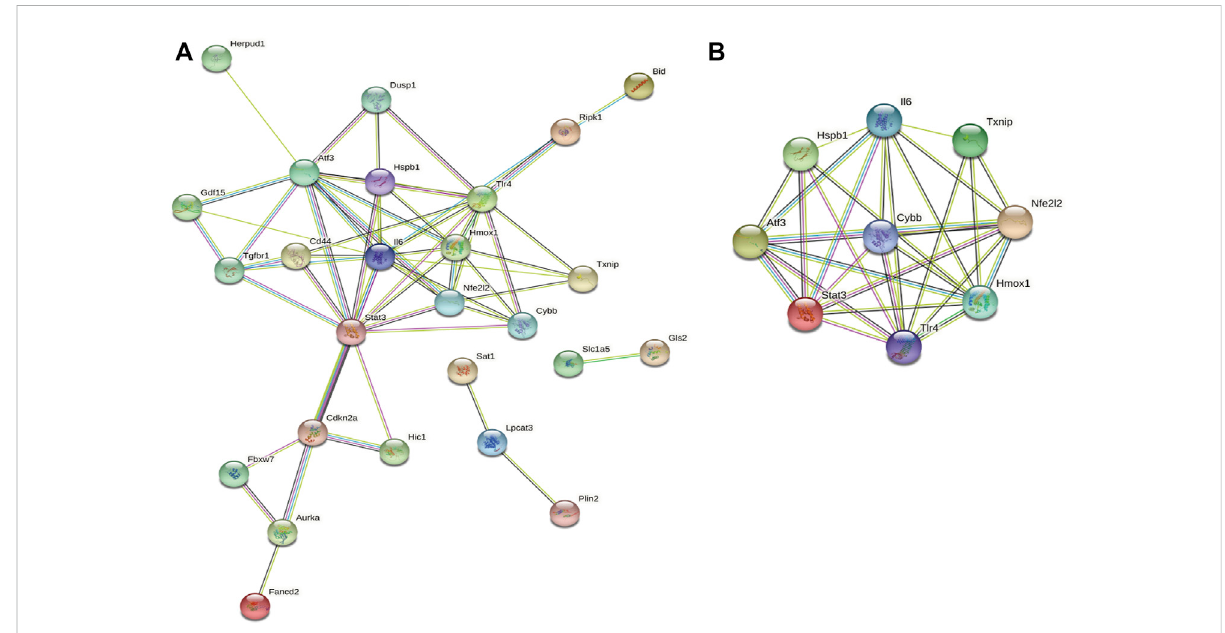
FIGURE 4 PPI analysis of ferroptosis-related DEGs. (A) PPI network of ferroptosis-related DEGs. (B) Gene clustering based on the MCODE algorithm.